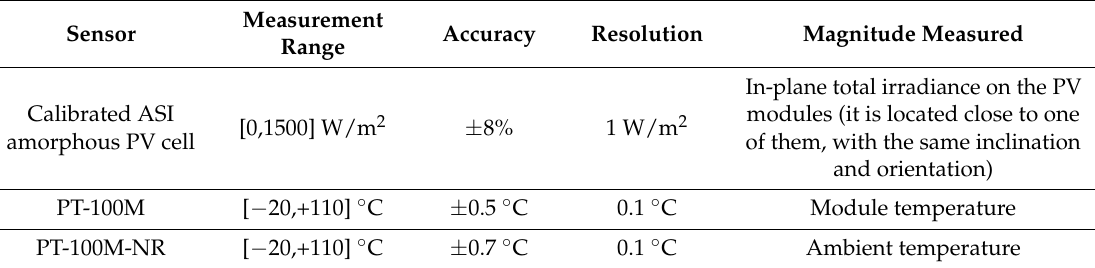
Table 4. Irradiance and temperature